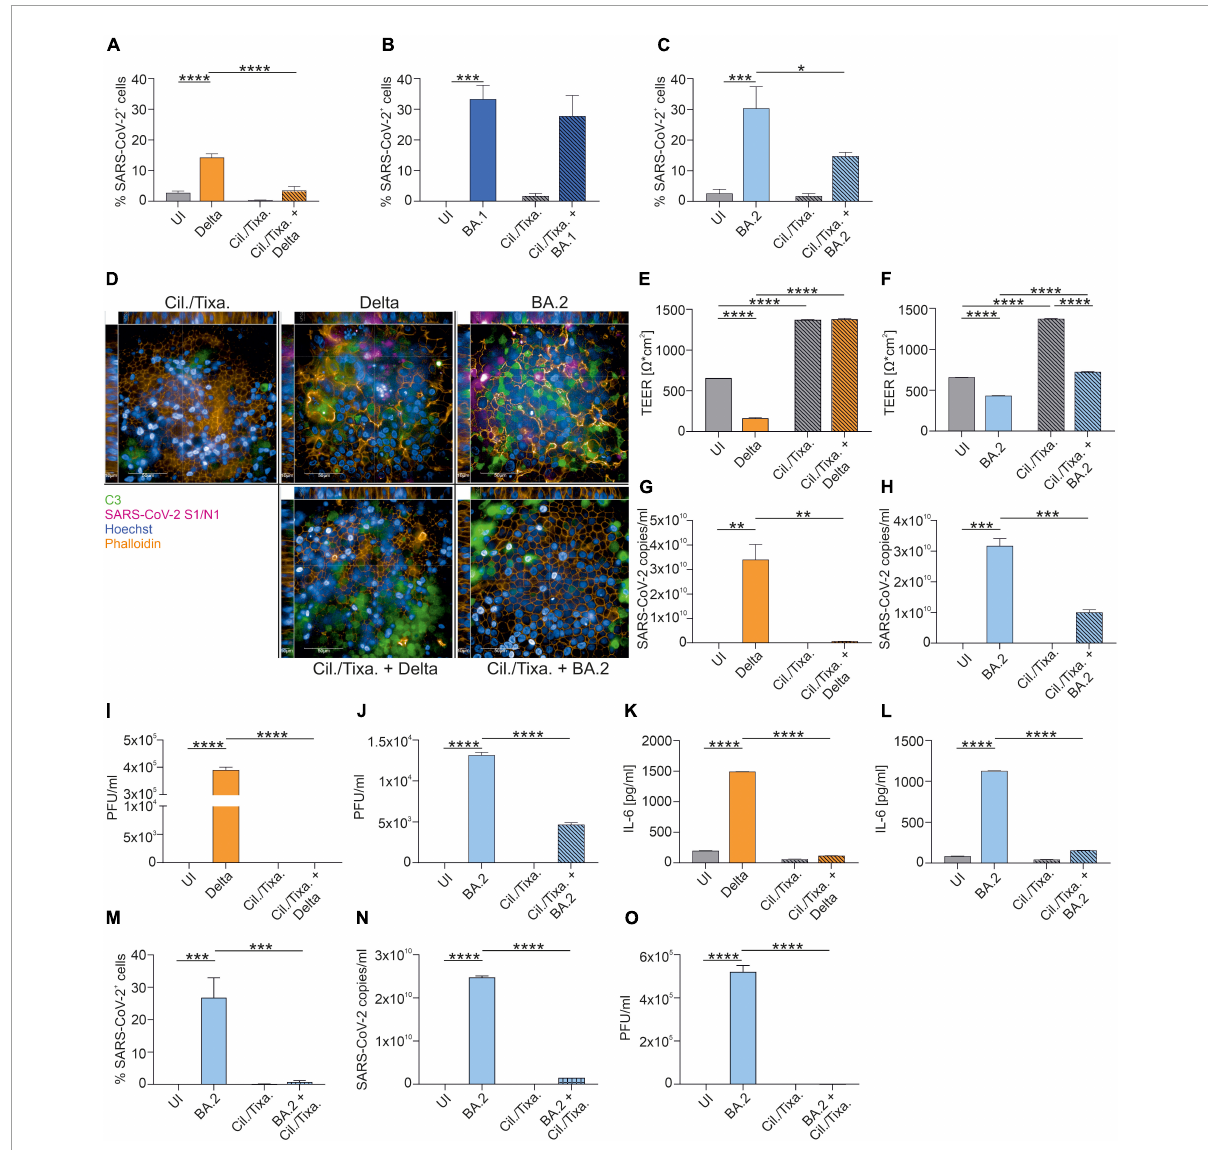
FIGURE2 Efficacy of the prophylactic and therapeutic use of mAb cocktail Cilgavimab/Tixagevimab against SARS-CoV-2 Delta, BA.1 or BA.2. After 72 h of infection, NHBE cells grown on transwell filters were analyzed by immunofluorescence with the Harmony Software and percentage of SARS-CoV-2-positive cells were determined for Delta- (A) , BA.1- (B) and BA.2-infected cells (C) . Background signals due to the analysis were detected in UI and Cilgavimab/Tixagevimab (Cil./Tixa.) treated cells. (D) Representative pictures of XYZ stack are shown for the conditions where Cilgavimab/Tixagevimab pretreatment resulted in a significant reduction of SARS-CoV-2-positive cells shown in (A–C) . Scale bars represent 50 and 10 µ m as indicated. After 72 h of infection, TEER was measured from Delta- (E) or BA.2-infected HAE ± Cilgavimab/Tixagevimab (F) . Viral RNA was analyzed in Delta- (G) and BA.2-infected cells ± Cilgavimab/Tixagevimab (H) . Plaque Assays of supernatants from Delta- (I) and BA.2-infected cultures ± Cilgavimab/Tixagevimab (J) were performed on Vero/TMPRSS2 cells. Concentration of IL-6 in the subnatants from Delta- (K) and BA.2-infected cultures ± Cilgavimab/Tixagevimab (L) were measured by ELISA. Cilgavimab/Tixagevimab was added to BA.2-infected cells after 6 h of infection and after 72 h of infection percentage of SARS-CoV-2-positive cells were determined (M) . Viral RNA was analyzed in BA.2-infected cells ± post-infected treatment of Cilgavimab/Tixagevimab (N) . Plaque Assays of supernatants BA.2-infected cultures ± post-infected treatment of Cilgavimab/Tixagevimab (O) were performed on Vero/TMPRSS2 cells. Statistically significant differences were determined by one-way ANOVA with Tukey correction. All values are means ± SEM; * P < 0.05; ** P < 0.01; *** P < 0.001; **** P < 0.0001. At least three independent experiments were